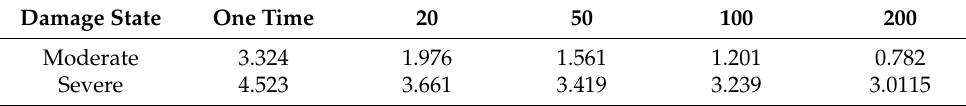
Table 5. Equivalent reliability index